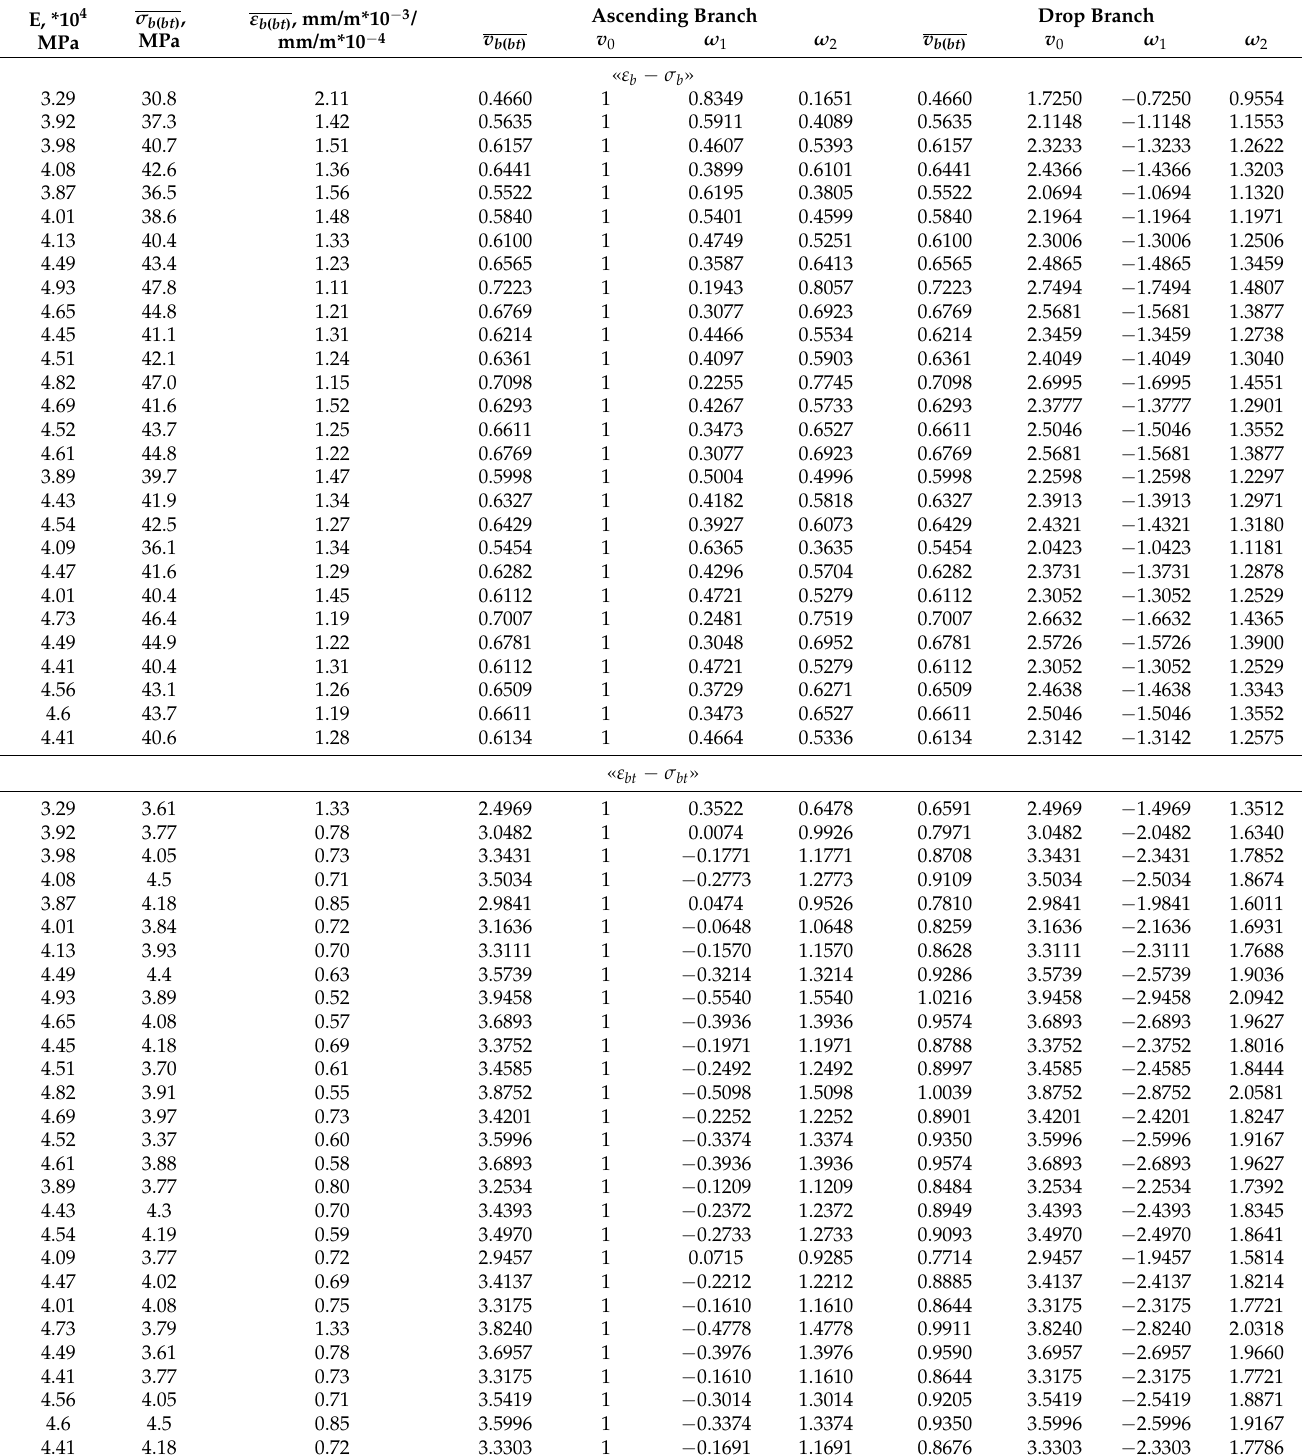
Table 10. The calculated coefficients for plotting compression “ ε b − σ b ” and tension “ ε bt − σ bt